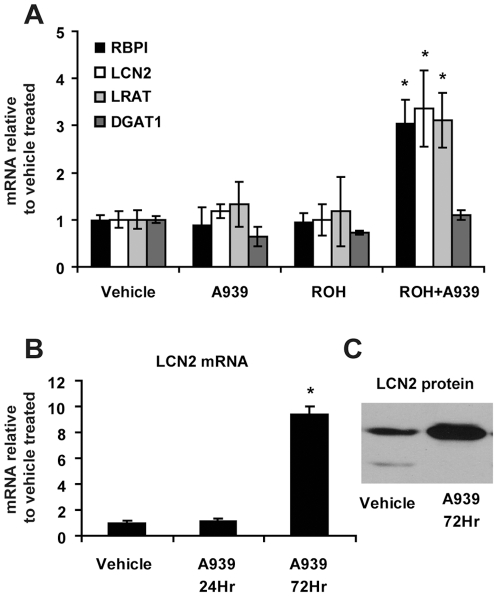
Loss of SCD1 activity in SEB-1 sebocytes increases retinoic acid target gene induction.A) SEB-1 human sebocytes were treated with vehicle alone, the SCD inhibitor A939572 (A939; 1 µM), free retinol (ROH; 1 µM), or both A939 and ROH for 18 hours. Total RNA was collected for assessment of expression of RBP1, LCN2, LRAT and DGAT1. Data are expressed relative to vehicle treated cells. B) SEB-1 cells were grown for the indicated times in the presence or absence of A939572 (A939; 1 µM) and total RNA was collected for assessment of LCN2 induction. C) Cellular protein expression of LCN2 increased after 72 hour treatment with A939 as well. Data represent mean ± SEM for n = 3 per group. * = p<0.05 vs. vehicle control.